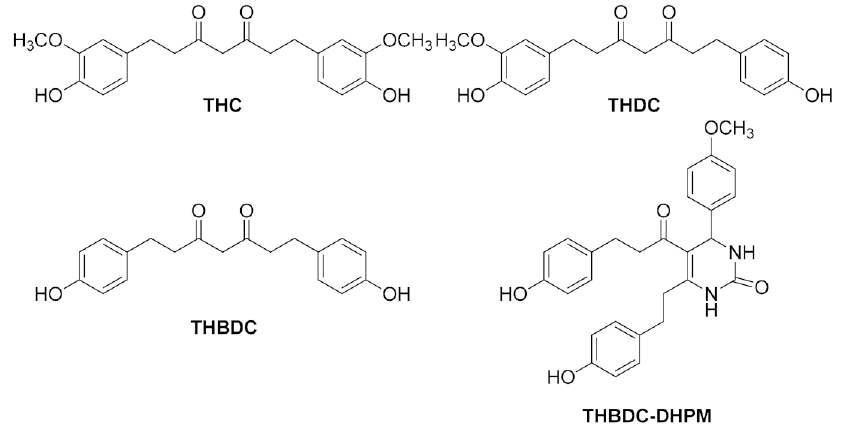
Figure 4. Structures of tetrahydrocurcumins (THCs)